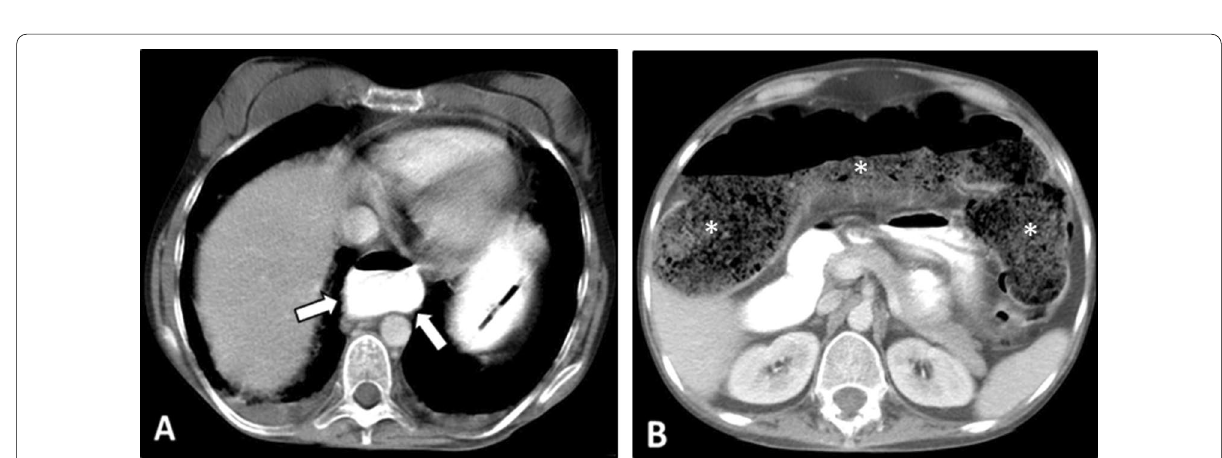
Fig. 19 Colonic pseudo-obstruction in a 35-year-old female with known scleroderma presenting with constipation, nausea, vomiting, and abdominal distension. CT scan with IV/oral contrast was done. Axial CT image ( A ) demonstrates dilation of the distal esophagus (thick white arrows), a common finding in scleroderma. Axial CT image ( B ) reveals marked diffuse dilatation of colon (*) without obvious wall thickening or abrupt transition point, suggestive for colonic pseudo-obstruction (Ogilvie